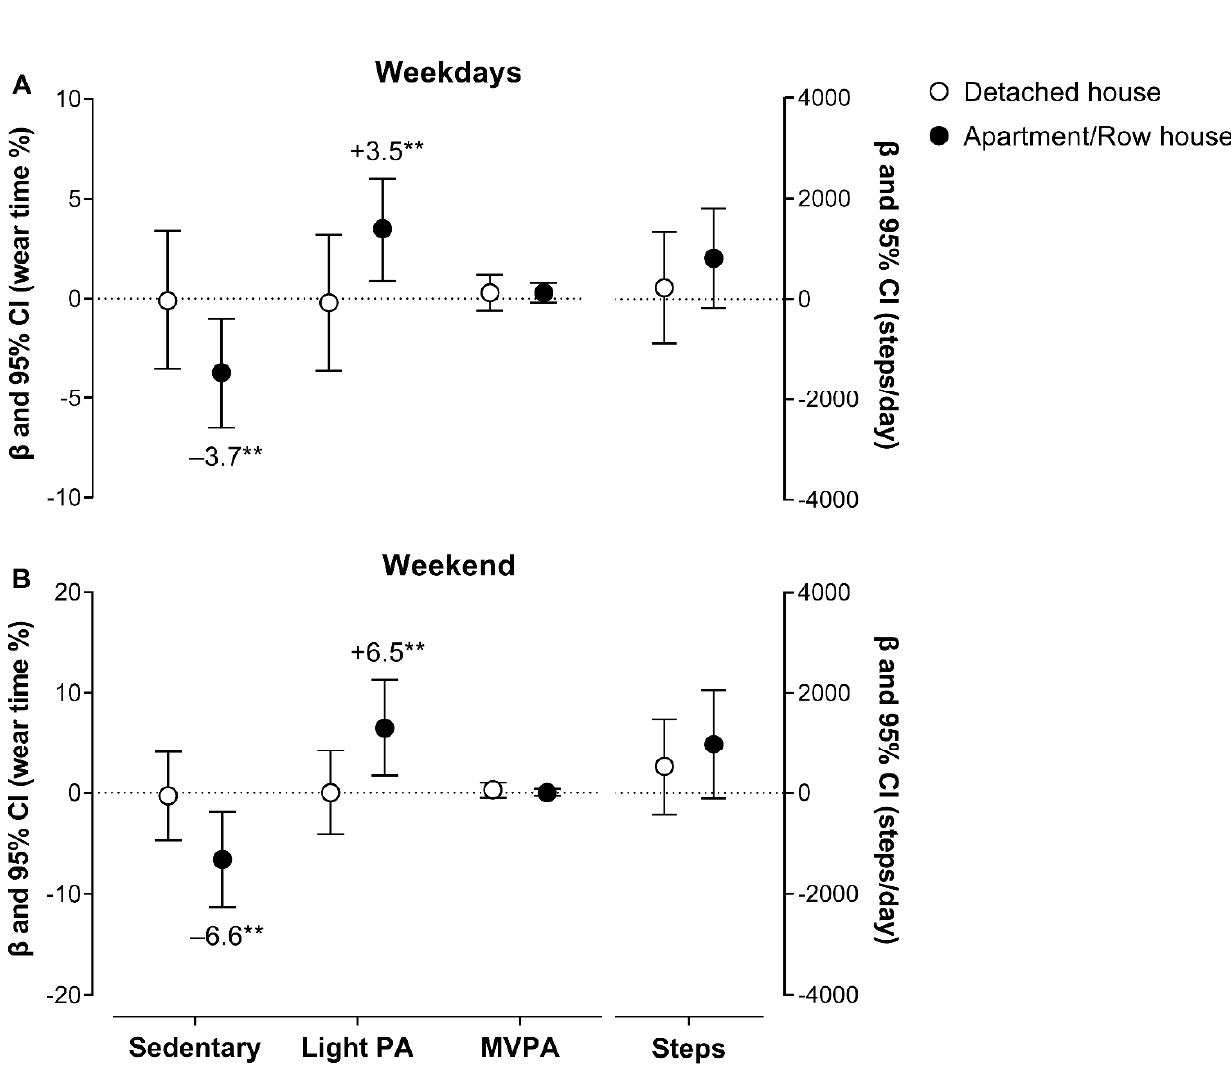
Figure 2. Objectively measured changes in the physical activity and sedentary behavior volume on weekdays (panel A ) and the weekend (panel B ) after COVID-19 vaccination among 32 older adults with hypertension residing in a detached house ( n = 17) or an apartment/row house ( n = 15). Values are expressed as contrast estimates ( β ) and the 95% Wald confidence interval (CI) of the estimated marginal mean (EMM) (contrast = EMM of after—EMM of before the COVID-19 vaccine). The models were analyzed using a generalized linear mixed model (steps per day models were controlled for the daily accelerometer wear time). ** p < 0.01. Abbreviations: MVPA, moderate-vigorous physical activity; PA, physical activity.